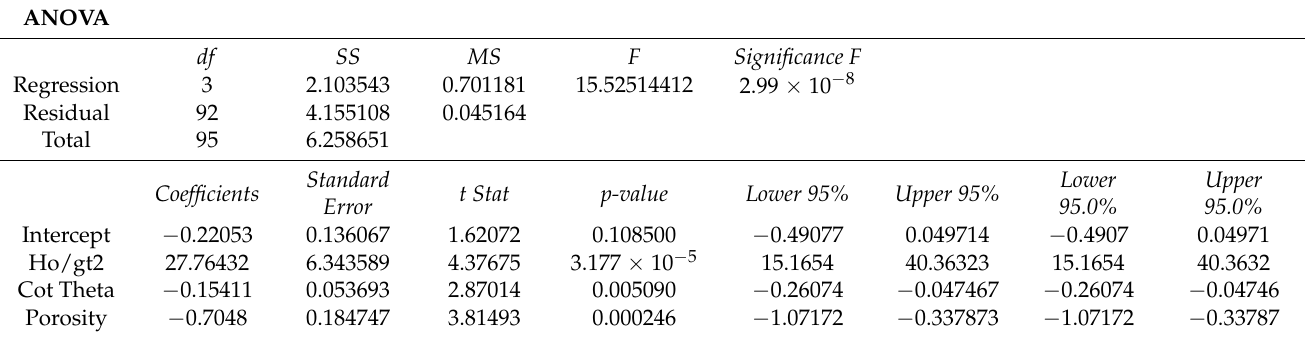
Table 9. Significance of independent variables on the dependent